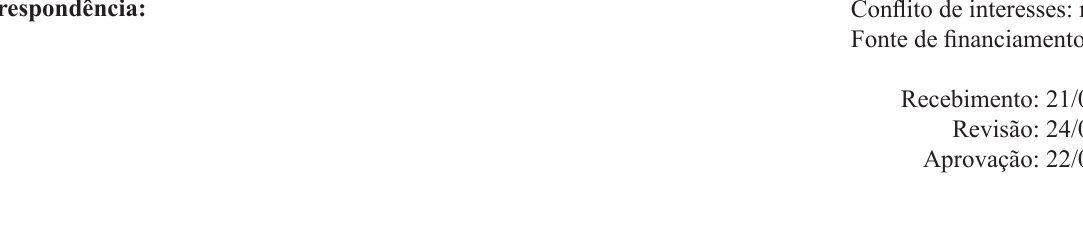
*Figuras coloridas disponíveis em